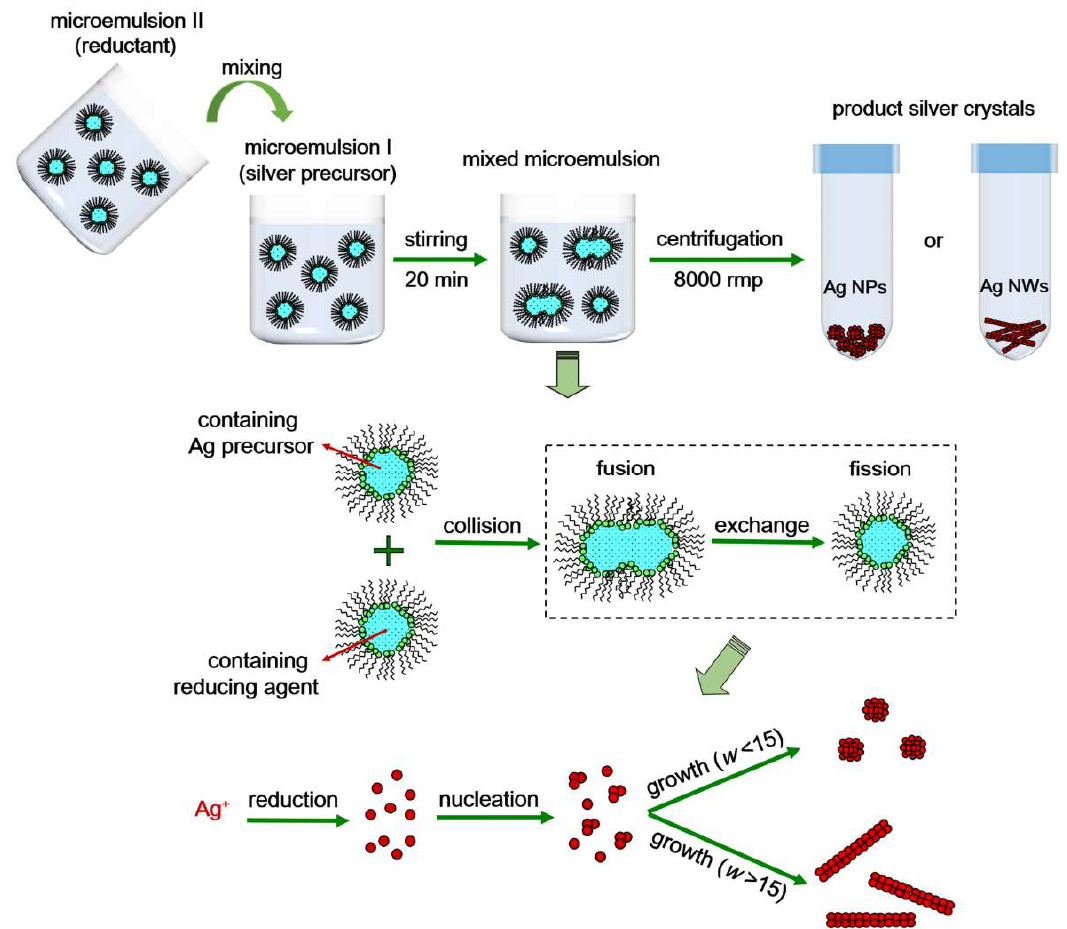
Figure 1. Schematic of the reaction process with a reverse microemulsion method.